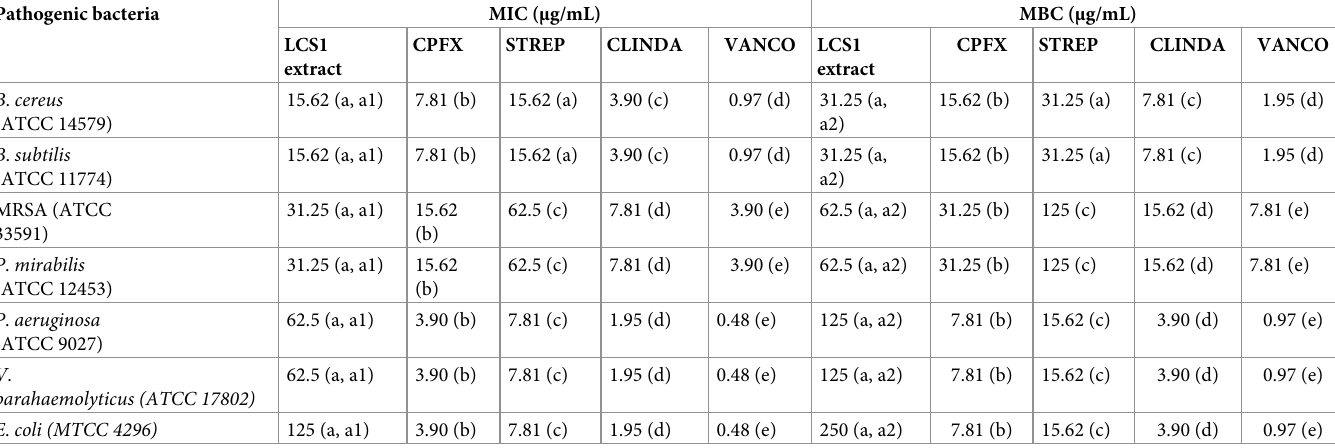
The five different letters (a, b, c, d, e) indicates potential statistical differences between the five testing agents- LCS1 and other four antibiotics regarding their MIC and MBC values respectively. The other two letters a1 and a2 indicates valid statistical difference between the MIC and MBC value of LCS1 extract (row